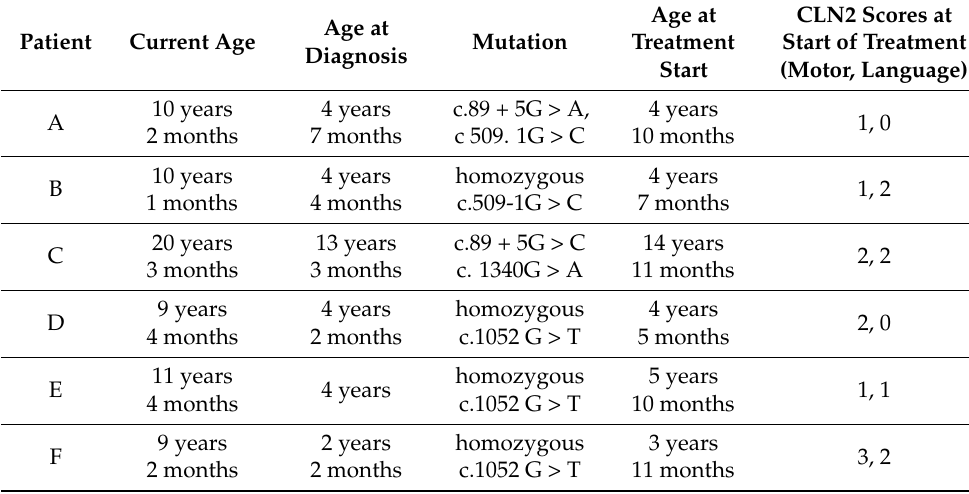
Table 1. Patient demographics. Six patients (A–F) are each shown in a different row.